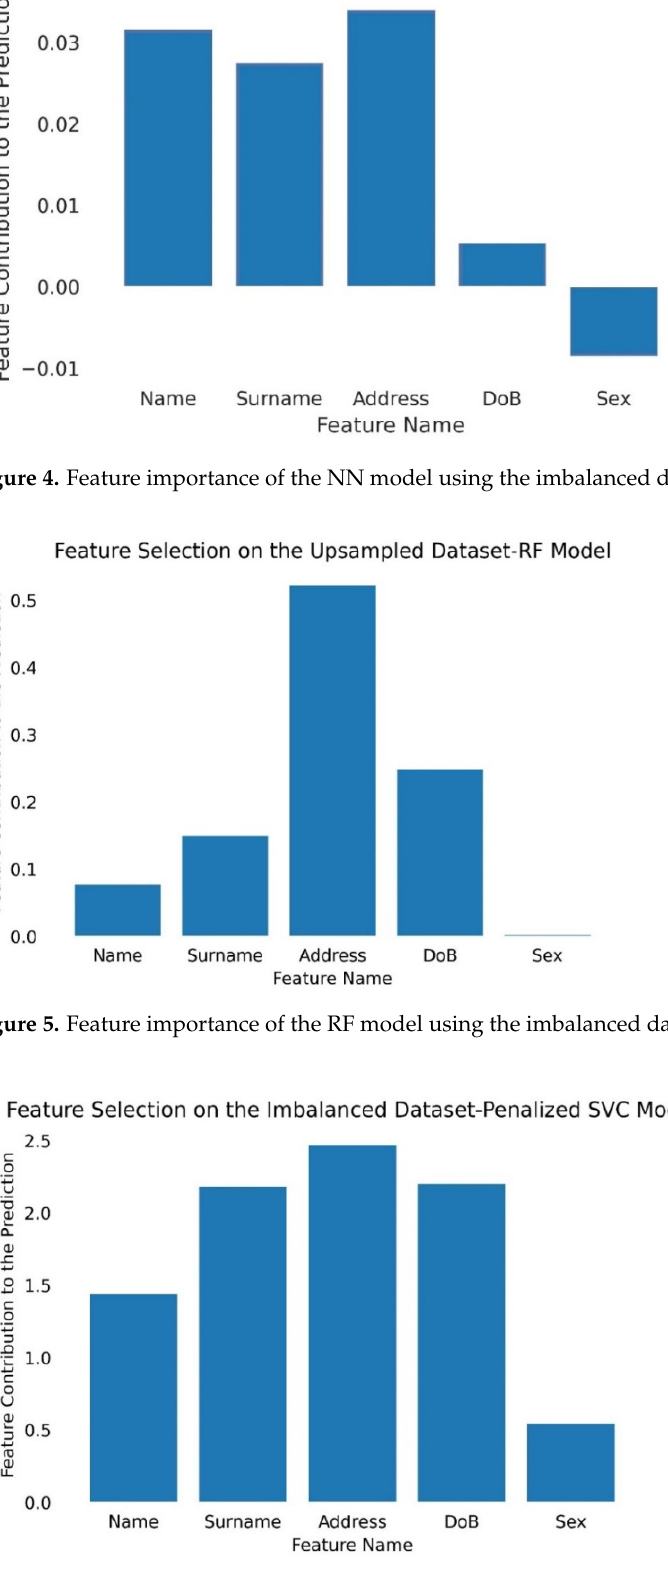
Figure 6. Feature importance of the SVC model using the imbalanced dataset as input.